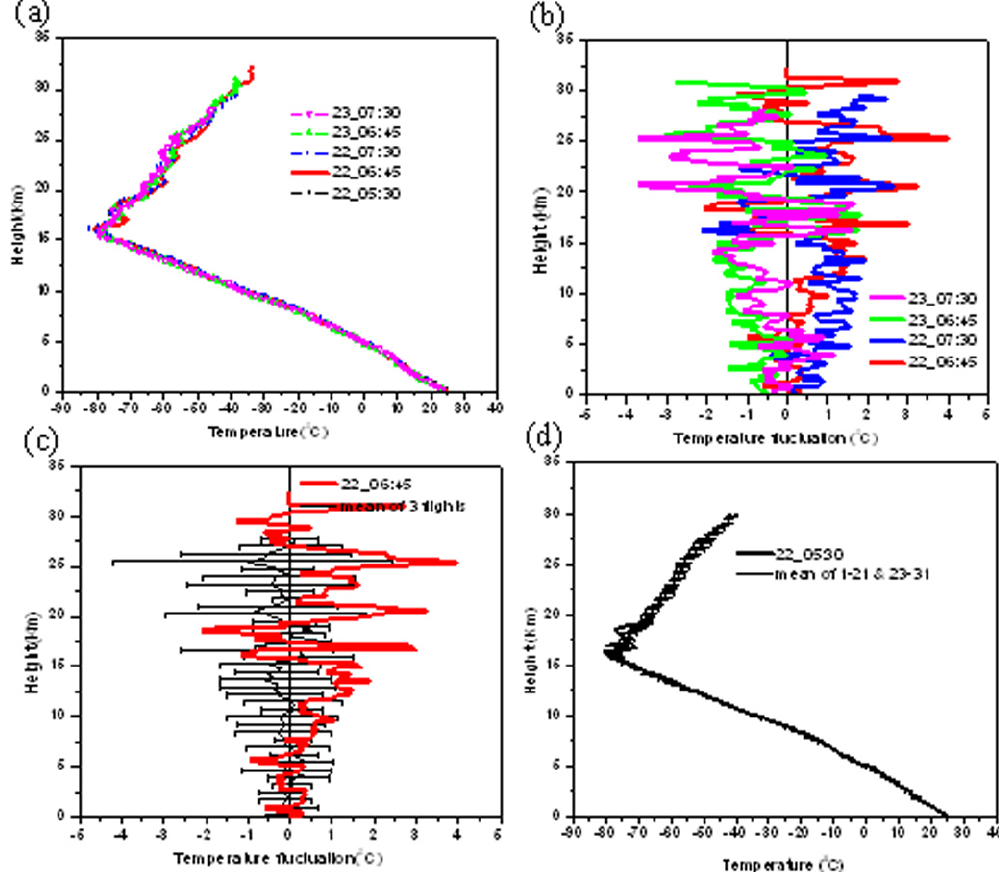
Fig. 2. (a) The height profile of the temperature in the 0–35km region on 22 July 2009 at 05:30 (black), 06:45 (red) and 07:30 (blue) IST and on the control day of 23 July at 06:45 (green) and 07:30 (magenta) IST. (b) Temperature fluctuation profiles on eclipse (22) and control day (23) of July 2009. (c) Temperature fluctuation profiles at 06:45 (red) IST on eclipse day and mean fluctuation profile with standard deviations. (d) The height profile of the temperature at 05:30IST on the eclipse day and mean temperature with standard deviation of non-eclipse days (1–21 and 23–31 July 2009) from IMD